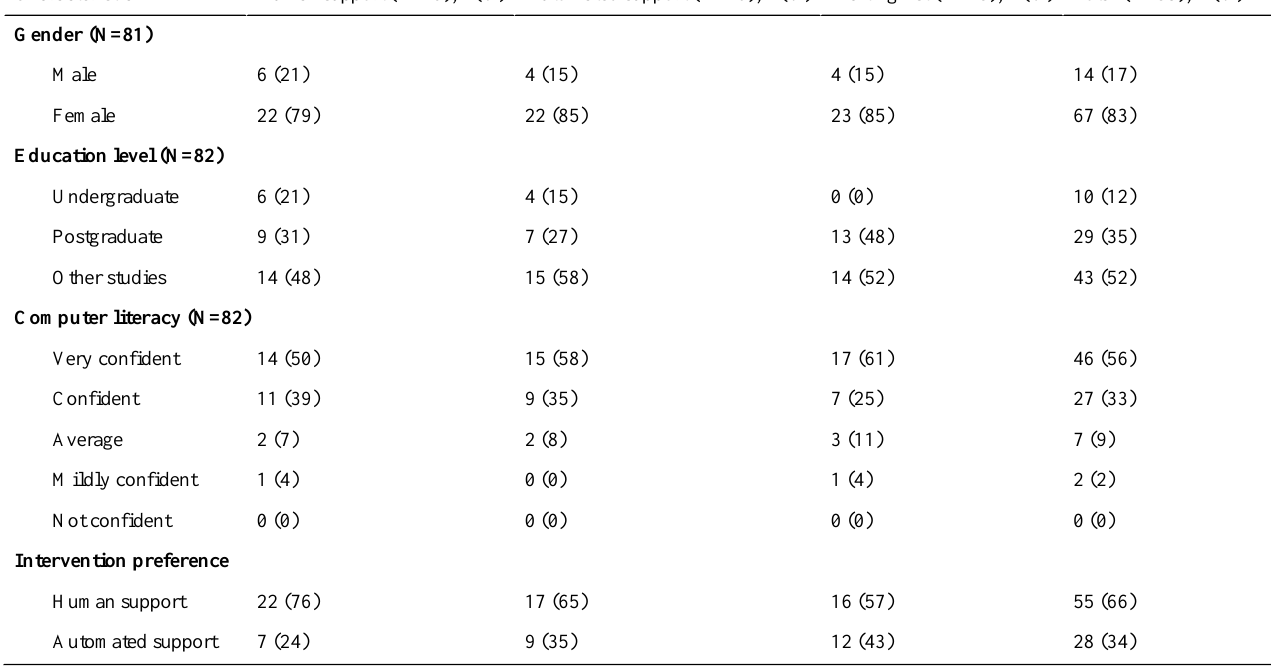
Table 2. Baseline characteristics of study